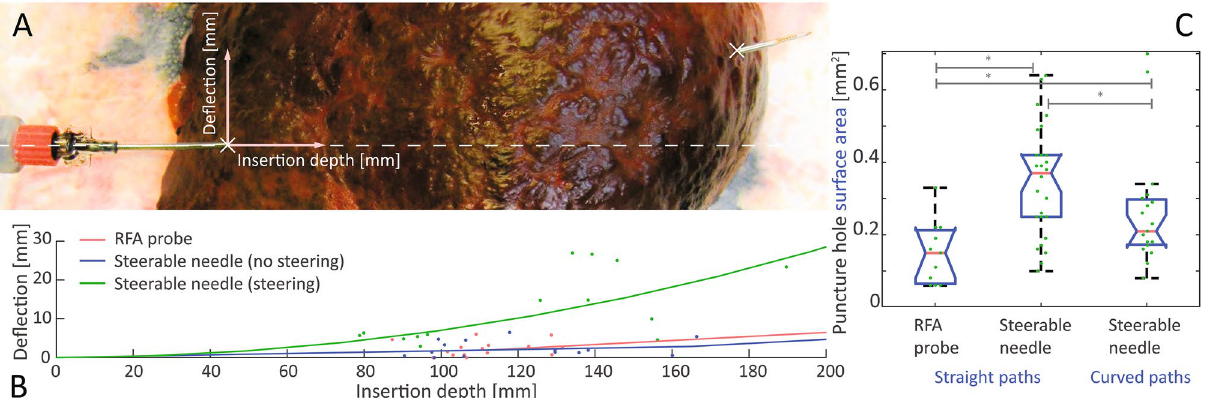
Figure 3. Illustration of insertion depth and needle deflection ( A ), and summary of deflection data ( B ) for punctures in fresh, cirrhotic liver explants ( A ), using the RFA probe and steerable needle v2, along straight and curved paths. Also shown are summary boxplots and individual data points ( C ) of histological tissue damage (mm 2 ) after the insertions. The asterisks indicate Wilcoxon rank sum test differences (α = 0.05).